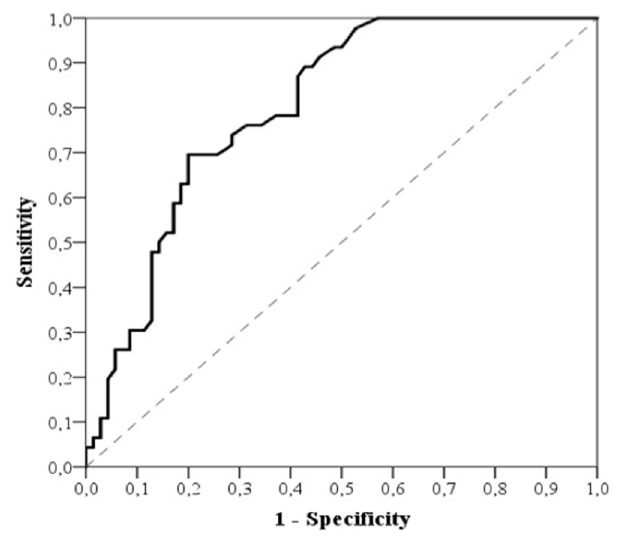
Fig. 2 - The receiver-operating characteristic analysis of preoperative neutrophil-lymphocyte ratio for postoperative hospital length of stay. The cutoff value was 0.80. The area under the curve was 0.801± 0.040 (95% confidence interval 0.722 – 0.879; P<0.001).